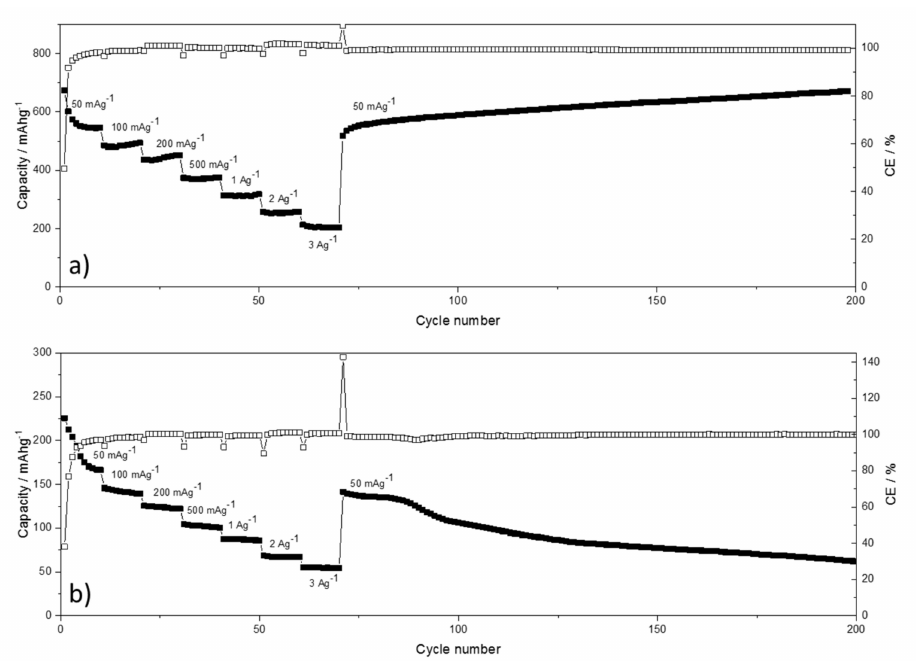
Figure 7. Rate capability and cycle stability plots BPO-C half-cell measurements against ( a ) lithium and ( b ) sodium. Lower and upper cut-o ff potentials were set to 0.005 and 3 V, respectively. The active material loading was around 1.3 mgcm − 2